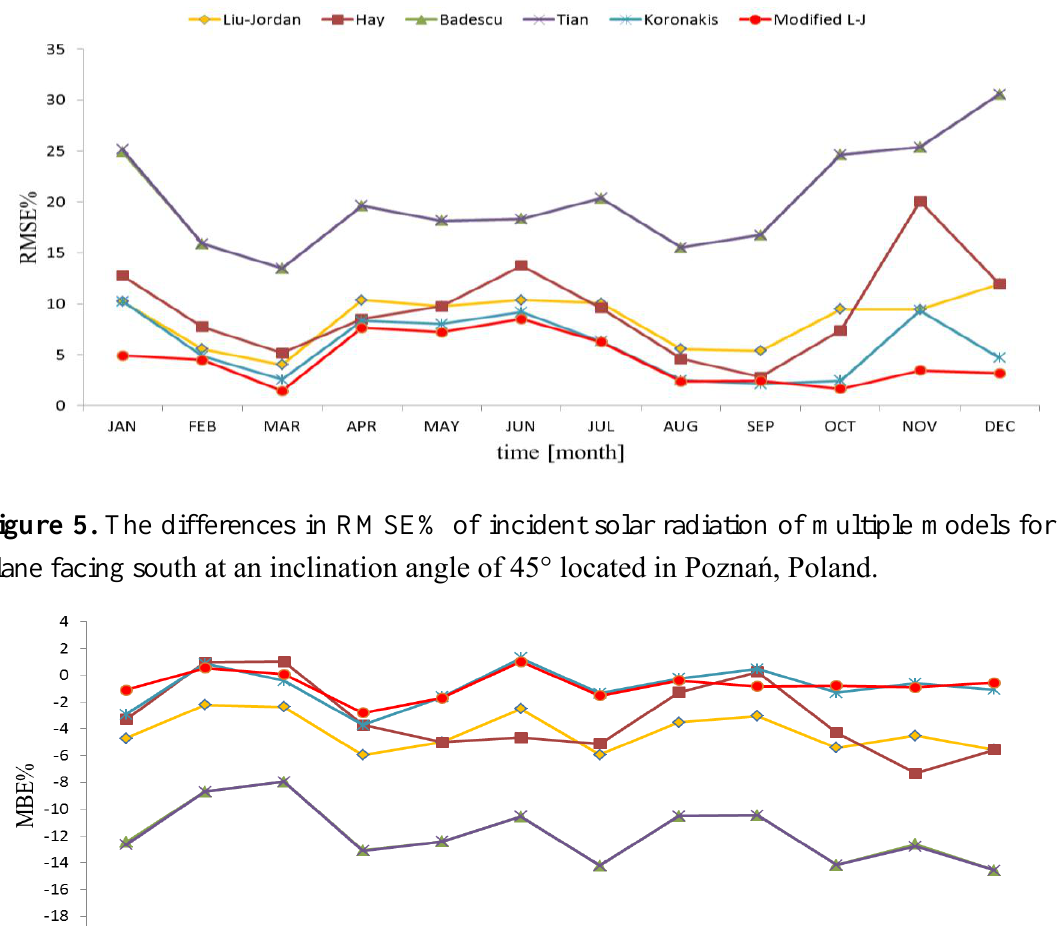
Figure 4. The differences in MBE% of incident solar radiation of multiple models for a plane facing south at an inclination angle of 30° located in Poznań, Poland.